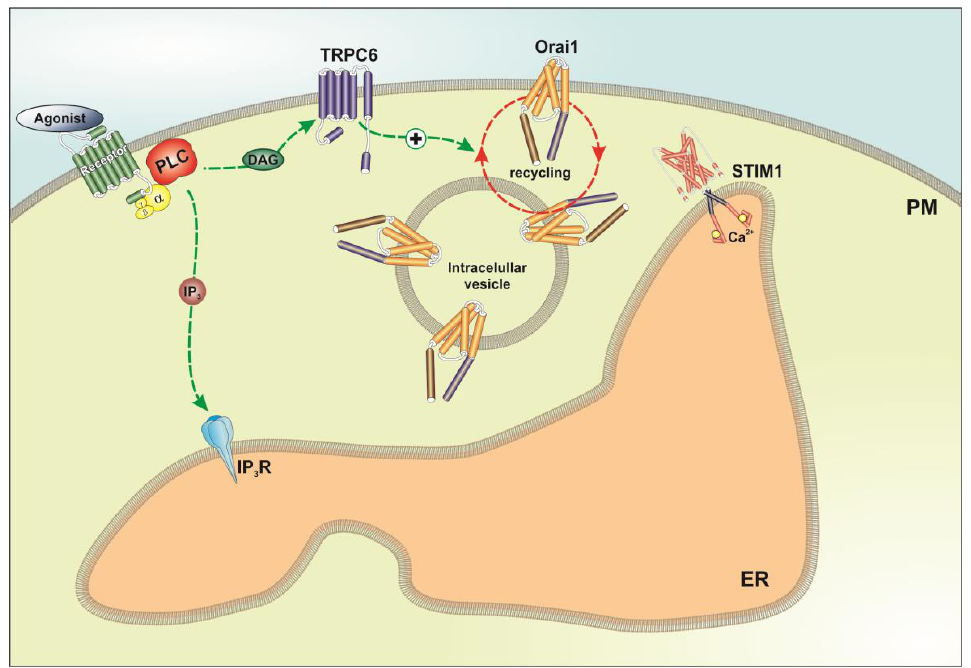
Figure 7. Proposed mechanism for the modulation of plasma membrane localization of Orai1 in